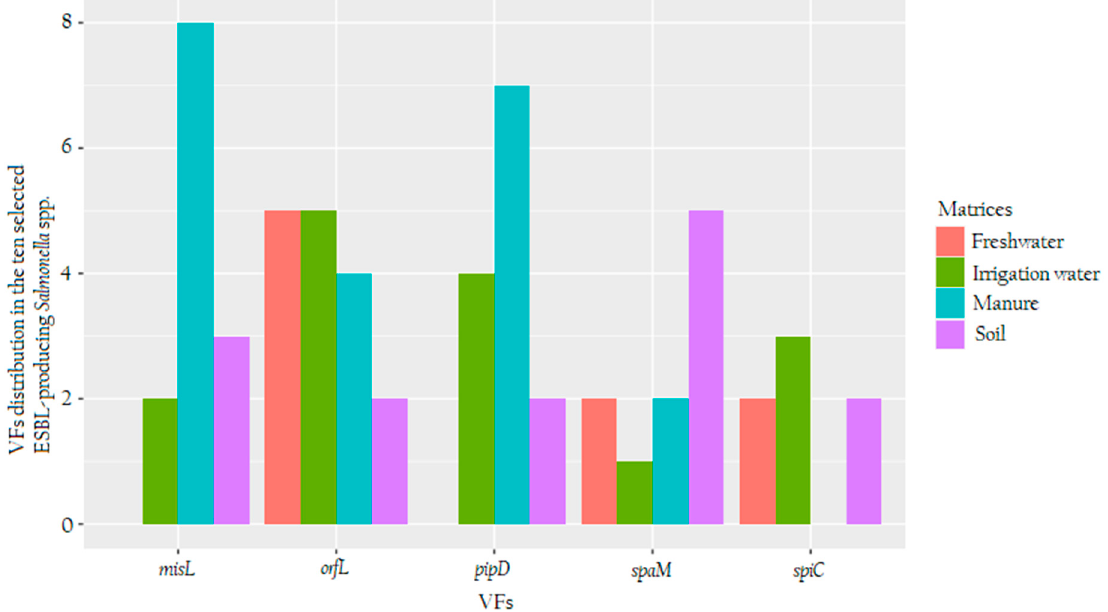
Figure 3. A clustered barplot showing the distribution of virulence factors (VFs) detected in the ten randomly selected ESBL-producing Salmonella spp. from soil (purple), manure (turquoise), irrigation water (green) and nearby freshwater (red). The X-axis shows the five targeted VFs, whereas the Y-axis shows the number of ARGs found in each assessed matrix.